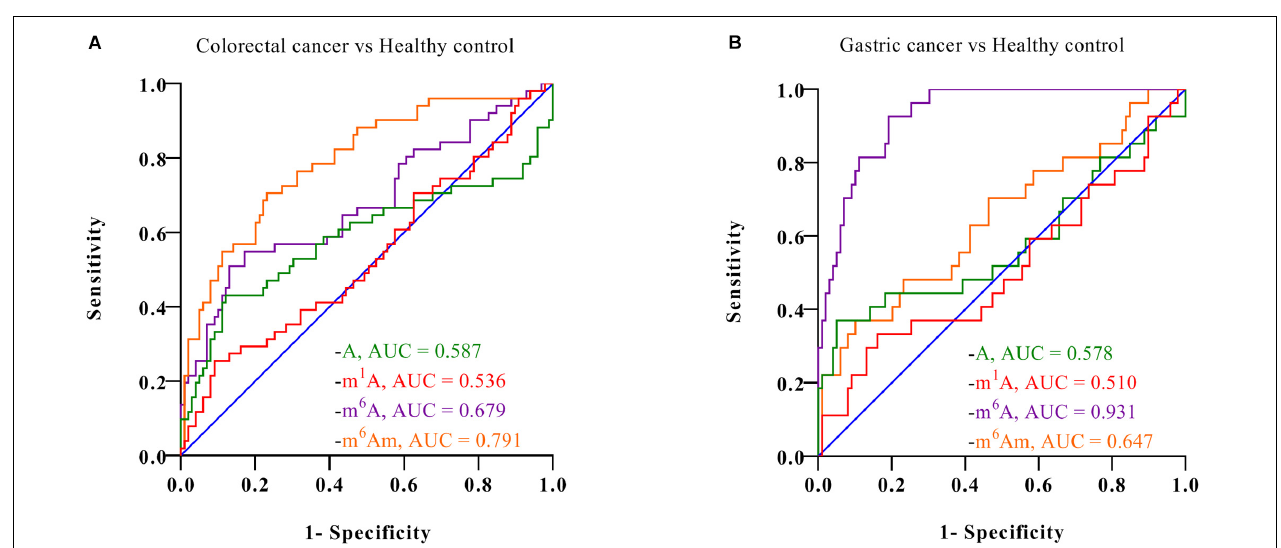
FIGURE 5 | ROC analysis for (A) colorectal cancer vs. healthy controls and (B) gastric cancer vs. healthy